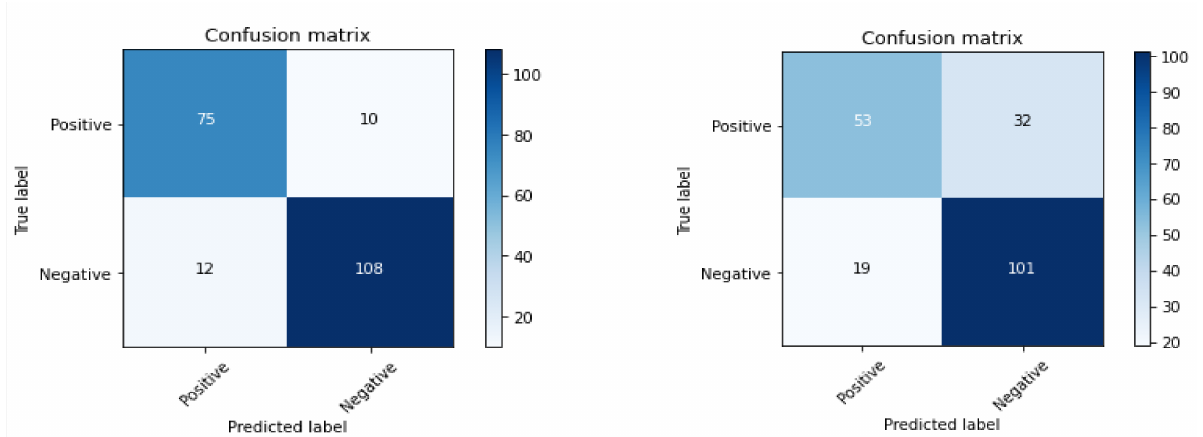
Figure 19. Confusion matrix generated by the DenseNet121 and ResNet50V2 models.